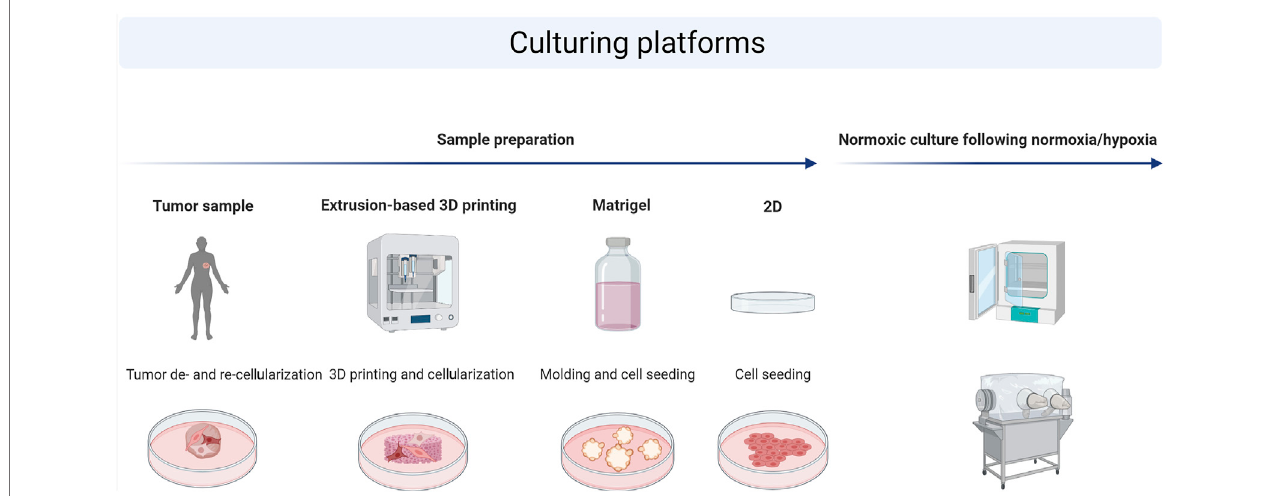
FIGURE 1 | Schematic illustration of the experimental work fl ow. The following platforms were used for cell culture on patient-derived scaffolds (PDS), 3D printed scaffolds(3DPS), molded Matrigel, orin2Dculture plates.Cellswereseededontop ofeach platform, cultured for3 weeks(3D)or72 h (2D)followedbya48 hculture in either normoxia or hypoxia, and analyzed on gene expression and protein levels using qPCR or Western blot, respectively.